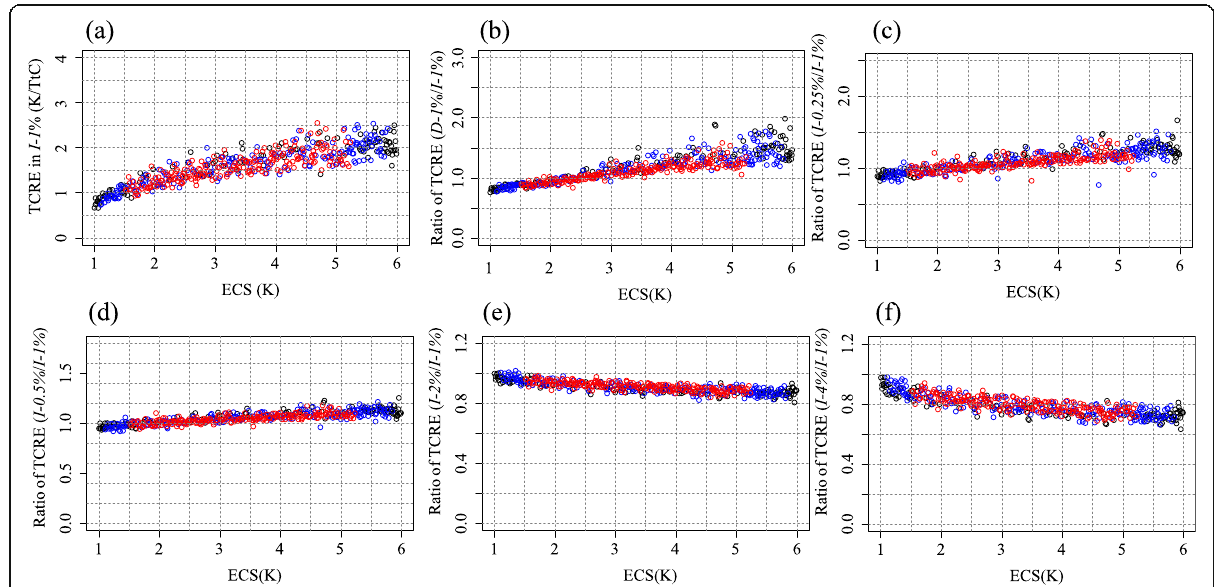
Fig. 3 The correlation between the ECS and a the TCRE under the I - 1 % scenario, and b – f the relative change in the TCRE from that of the I - 1 % for the other scenarios: b D - 1 % (starting from a non-equilibrium state), c I - 0.25 %, d I - 0.5 %, e I - 2 %, and f I - 4 %. The red, blue, and black circles indicate members with weights of > 0.5, 0.1 – 0.5, and < 0.1, respectively. Note that each sub-figure has a different y